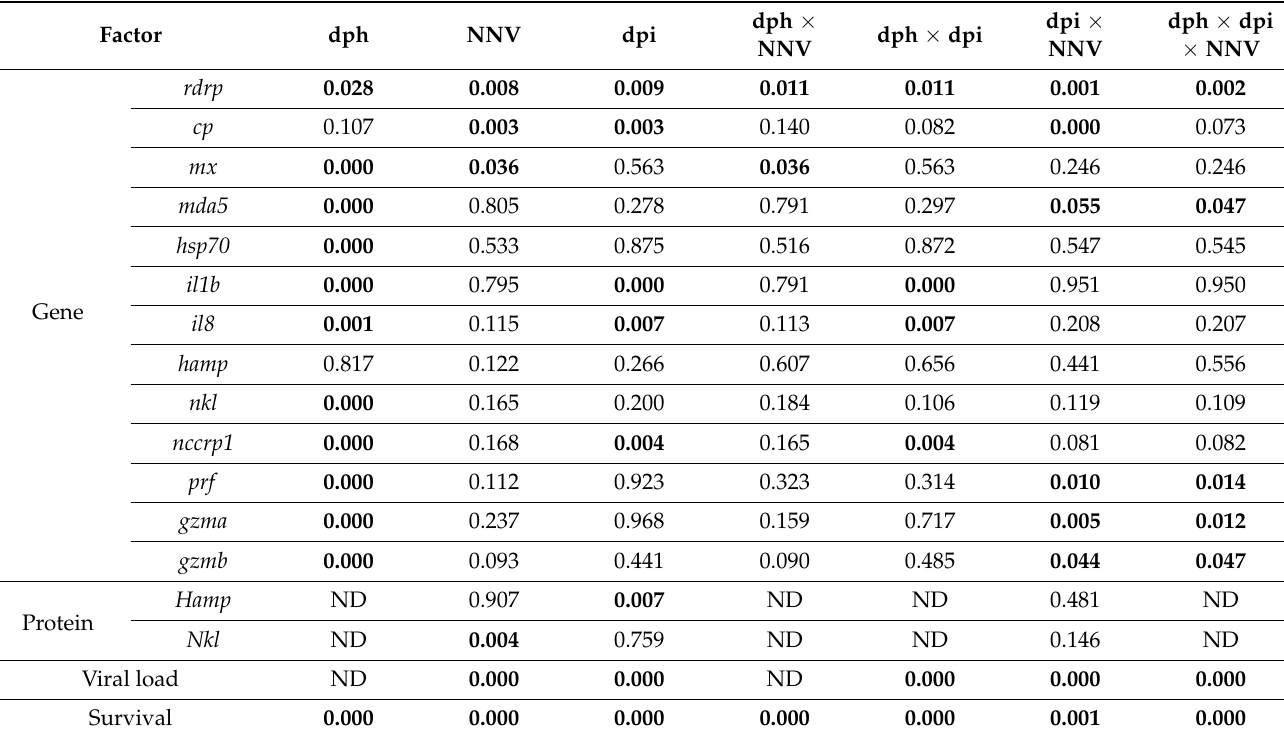
Table 1. Summary of the ANOVA results in 37 or 86 days post-hatching (dph) gilthead seabream larvae infected by immersion with RGNNV/SJNNV or SJNNV/RGNNV nodavirus (NNV) reas- sortants and sampled at 1, 4 or 7 days post-infection (dpi). Significant values ( p < 0.05) are in bold. ANOVA, analysis of variance; rdrp , NNV RNA-dependent RNA polymerase; cp , NNV coat pro- tein; mx , interferon-induced GTP-binding protein Mx; mda5 , melanoma differentiation-associated protein 5; hsp70 , heat-shock protein 70; il1b , interleukin 1 beta; il8 , interleukin 8; hamp , hepcidin; nccrp1 , non-specific cytotoxic cell receptor protein 1; prf , perforin; gzma , granzyme A; gzmb , granzyme B. ND, not determined due to insufficient